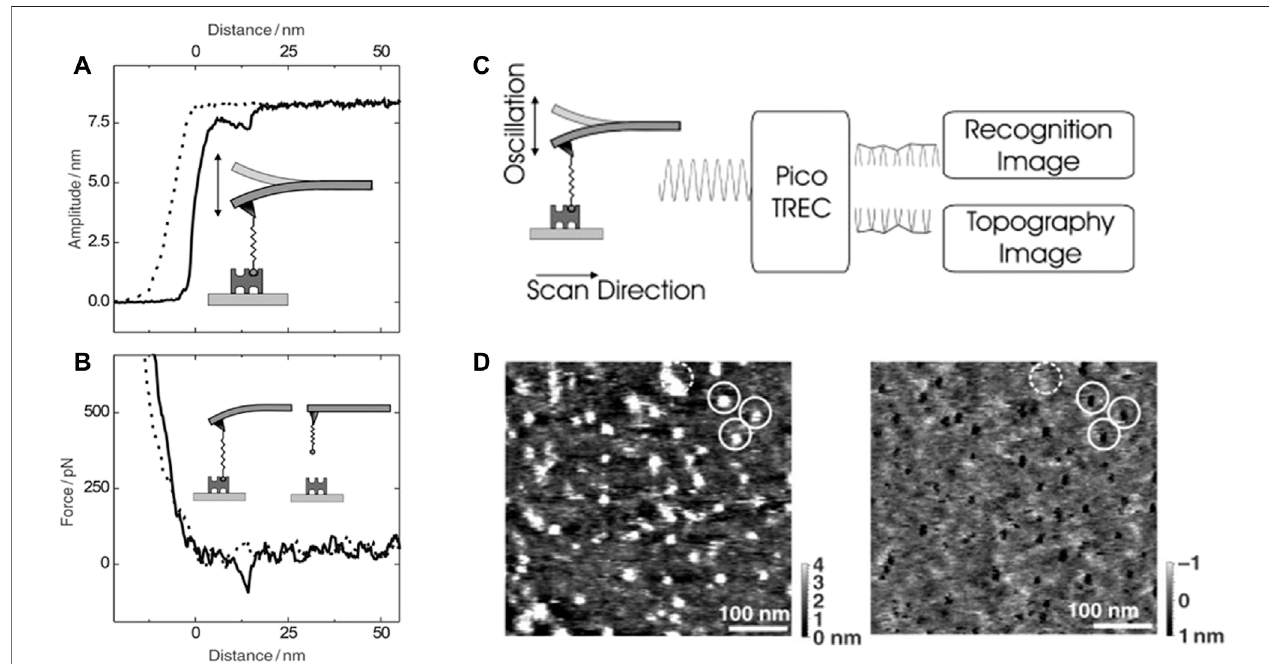
FIGURE 2 | (A – B) Amplitude – distance and force – distance cycle demonstrating a single rupture of avidin – biotin bond. (A) A single rupture event was observed at 14 nm in the amplitude-distance cycle causing amplitude to decrease by ≈ 1 nm. (B) The same rupture event was simultaneously observed in the force – distance cycle with rupture force of ≈ 80 pN. (C) Principle of TREC imaging: The cantilever oscillation comprises of lower and upper parts, yielding topography and recognition images simultaneously. (D) MicasubstratewasfunctionalizedwithAvidinandimagedwithabiotinfunctionalizedAFMcantilevertip.Brightdotsinthelefttopographyimage is well correlated with dark spots in right recognition image; scan size, 500 nm; spots within the dashed circle in the topographical image represent structural components and devoid of speci fi c interaction (Ebner et al.,